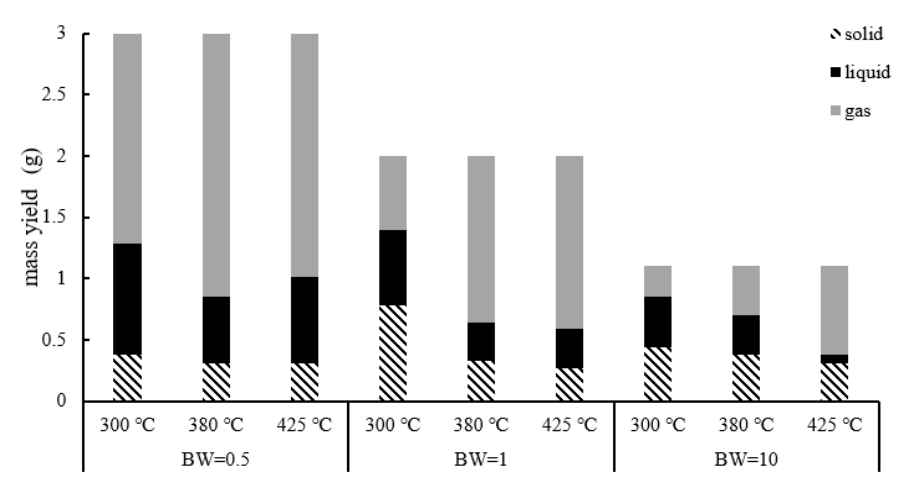
Figure 5. Mass balance of group 1.